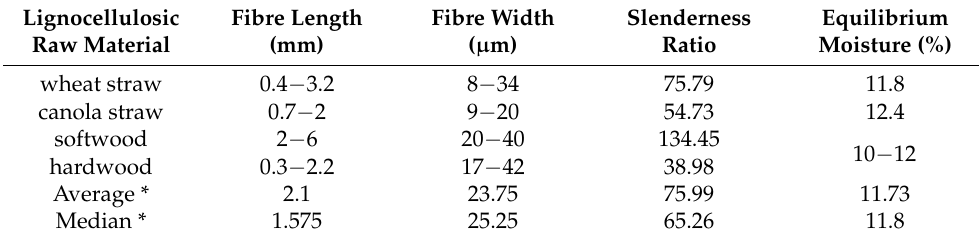
Table 2. Properties of the materials.